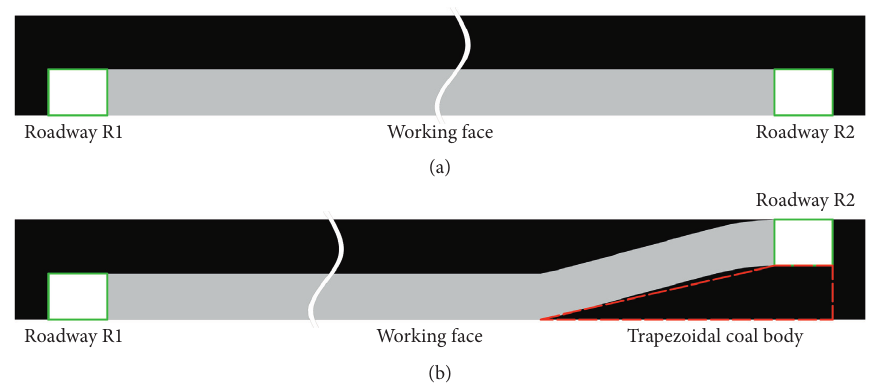
Figure 1: Active panel diagram. (a) CLTCC. (b)